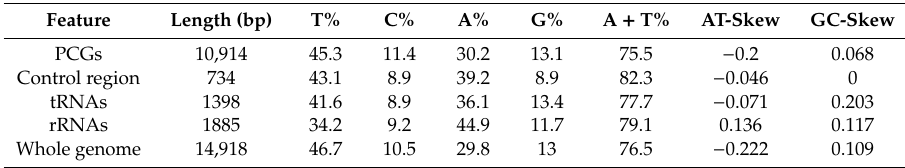
Table 4. Nucleotide composition and skewness comparison of di ff erent elements of the Tituria sagittata mtgenome.